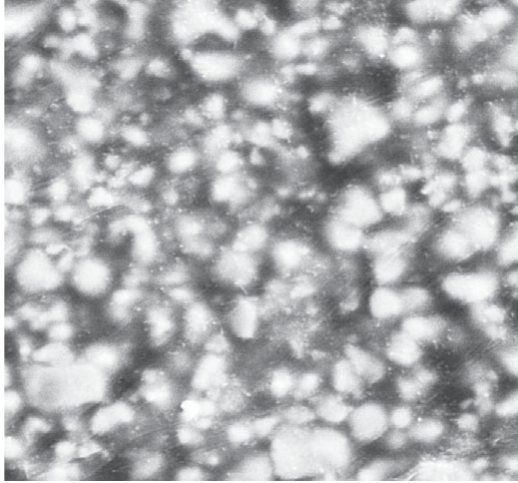
Figure 7. SEM photomicrograph of the (PZT/PVDF-HFP) 50/50 vol.% composite film (magnification 5000×).